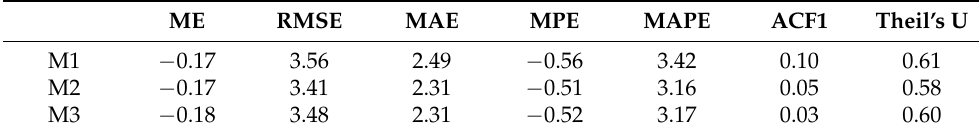
Table 1. The depression’s hybrid model accuracy